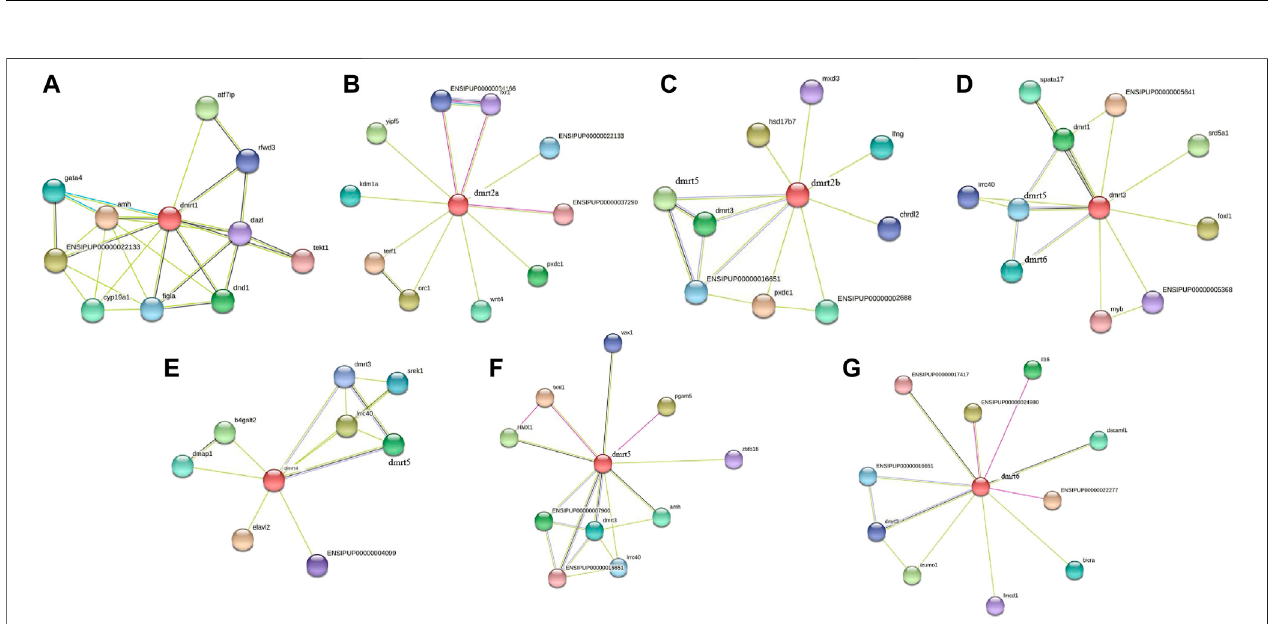
FIGURE 5 | Interaction network analysis of IpDmrt proteins. Images (A) , (B) , (C) , (D) , (E) , (F) , and (G) show the protein interaction network of IpDmrt1, IpDmrt2a, IpDmrt2b, IpDmrt3, IpDmrt4, IpDmrt5, and IpDmrt6, respectively.